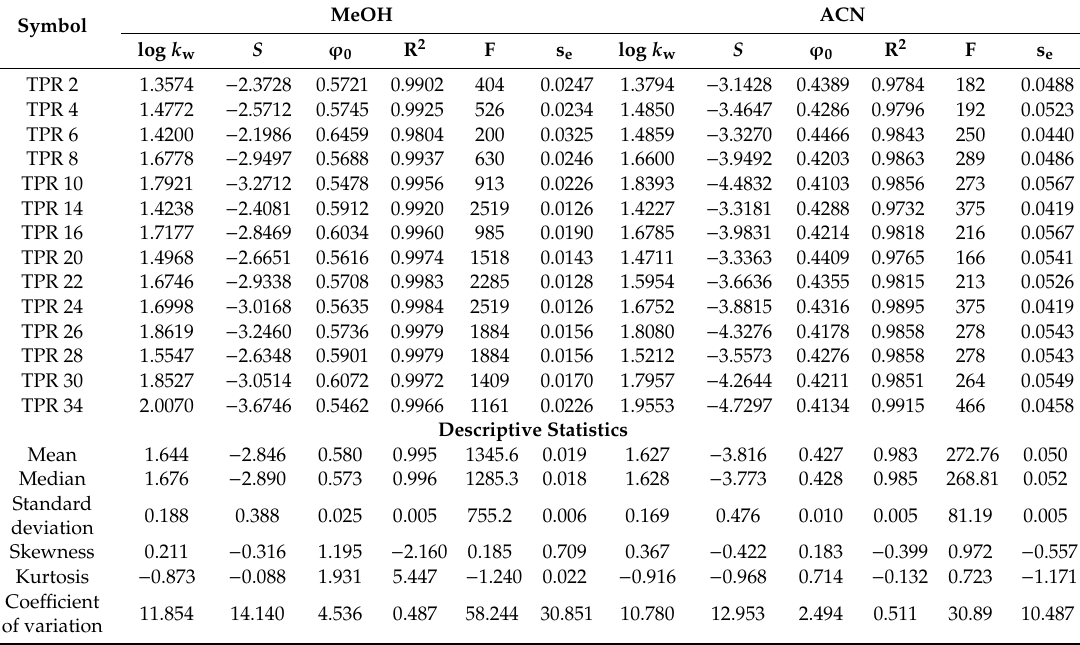
Table 2. Statistical estimates for the linear relationships (log k vs. the volume fraction of the organic modifier: methanol and acetonitrile) obtained on the Chirobiotic T